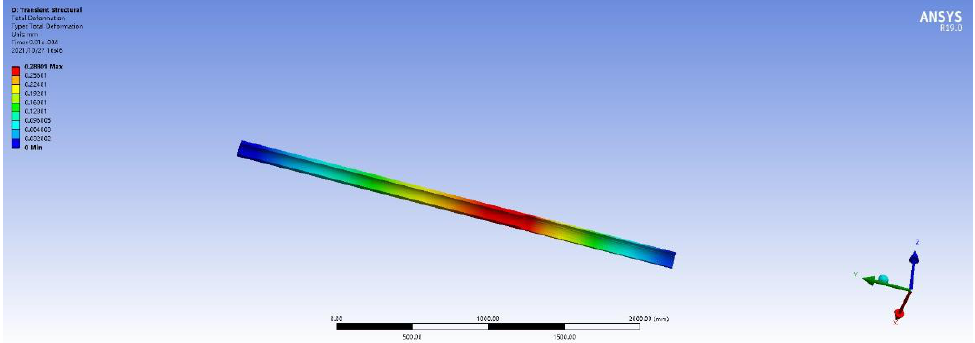
Figure 10. Total deformation of CrN/Cr composite coating barrel.